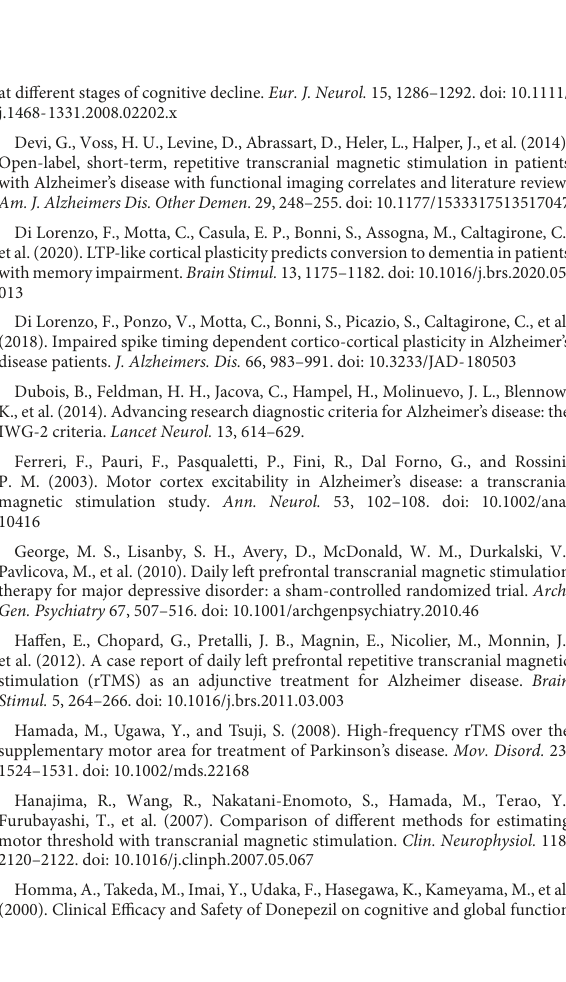
SUPPLEMENTARYFIGURE1 Left : The schema of eccentric coil. Spherical shape is ergonomically considered. Right : In the clinical trial model, two coils were equipped. SUPPLEMENTARYFIGURE2 LOESS curve smooth parameter = 0.6. To assess the clinical cutoff validity, we plotted scatter plots to display the relationship between MMSE baseline scores and the change from baseline in the ADAS-cog scores at week 4. Curves were fitted with the locally weighted scatter plot smoother (LOESS) function, with borders indicating 95% CI. MMSE, Mini-Mental State Examination; ADAS-cog, Alzheimer’s Disease Assessment Scale-Cognitive; RMT, resting motor threshold; CI, confidence